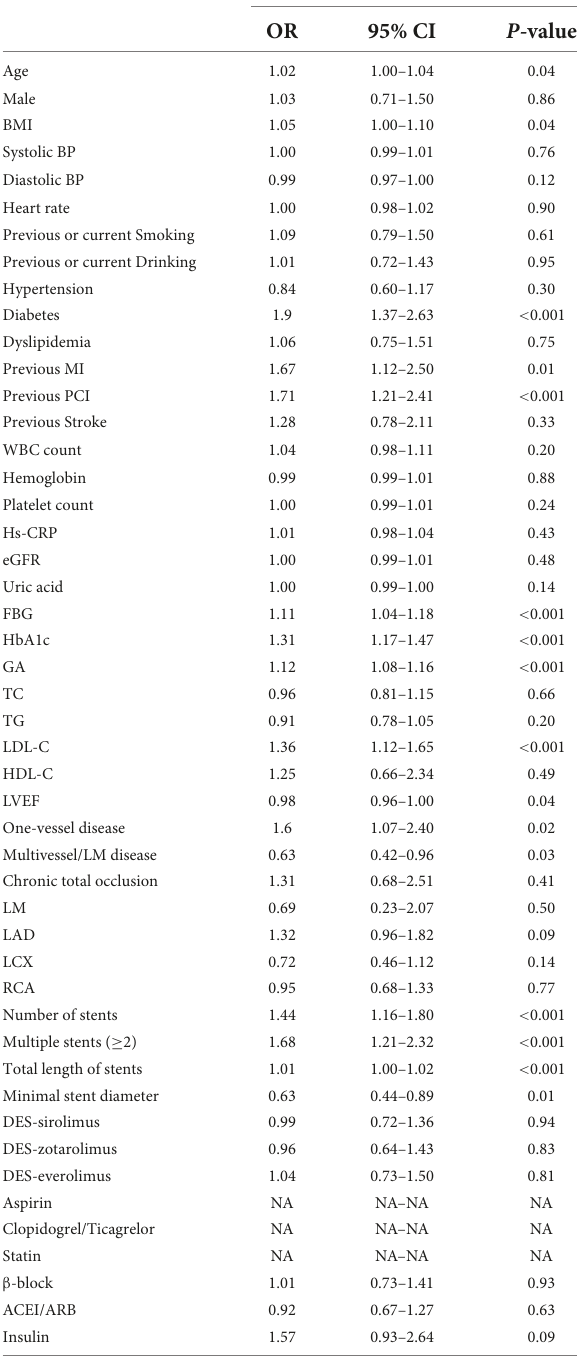
TABLE 3 Univariate logistic regression analysis for